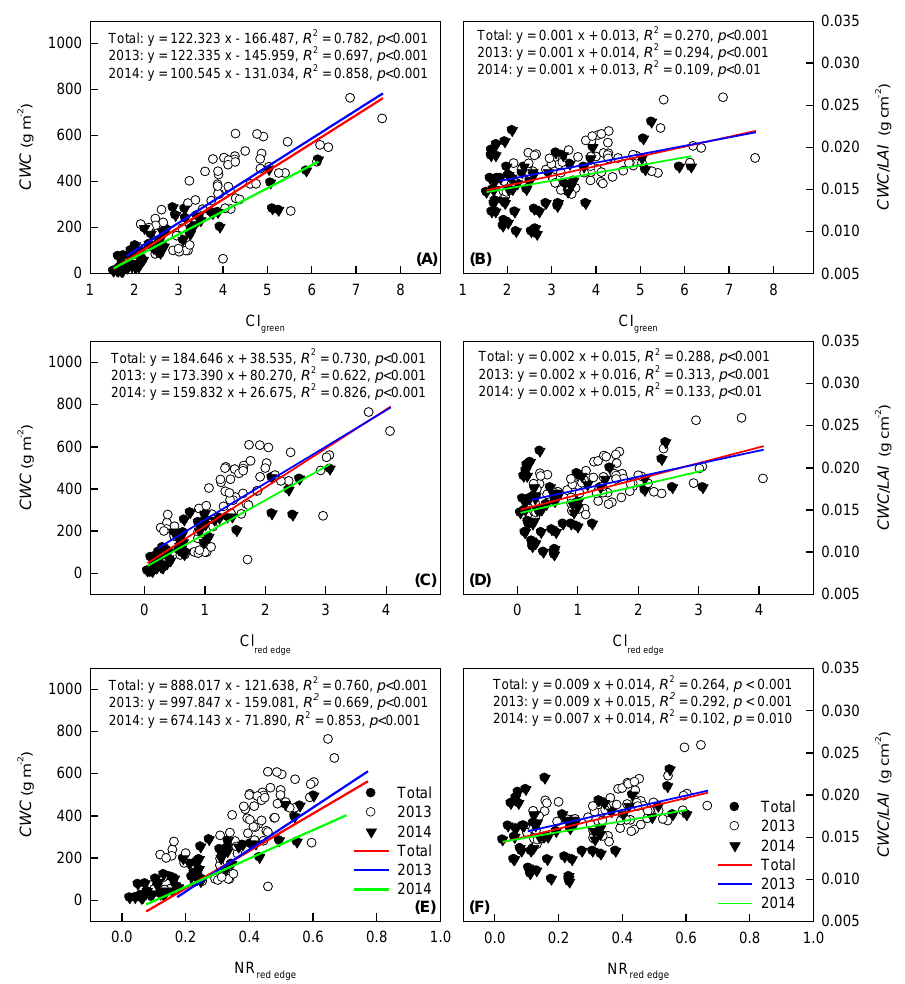
Figure 6. Relationships between CWC and 𝐸𝑊𝑇̅̅̅̅̅̅̅ ( CWC / LAI ) vs. CI green , CI red edge , and NR red edge for maize during the growing seasons of 2013–2014. ( A ) CWC -CI green , ( B ) 𝐸𝑊𝑇 ̅̅̅̅̅̅̅ -CI green , ( C ) CWC -CI red edge , ( D ) 𝐸𝑊𝑇 ̅̅̅̅̅̅̅ -CI red edge , ( E ) CWC -NR red edge , and ( F ) 𝐸𝑊𝑇̅̅̅̅̅̅̅ -NR red edge ; Figures 2 and 3 provide the definitions of